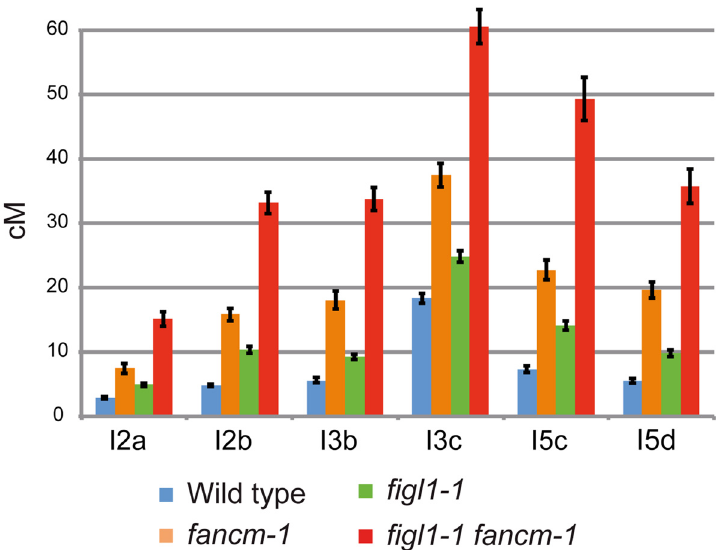
Fig 2. FIGL1 limits meiotic CO independently of FANCM. Genetic distances (in cM) measured from tetrad analysis in a series of intervals across Arabidopsis genome: I2a and I2b are adjacent intervals on chromosome 2 and so on for the other couples of intervals. Error bars: SD. On all intervals all genotypes are significantly different from each other (Z-test, p <